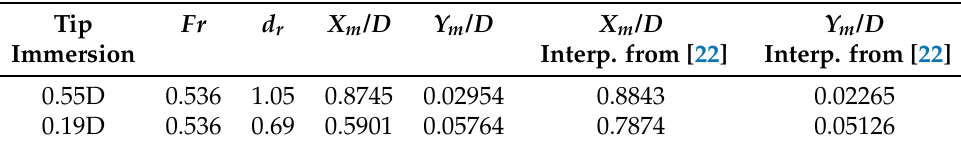
Table 3. Normalized maximum displacement of the free surface ( Y m / D ) and its location downstream the rotor ( X m / D ).